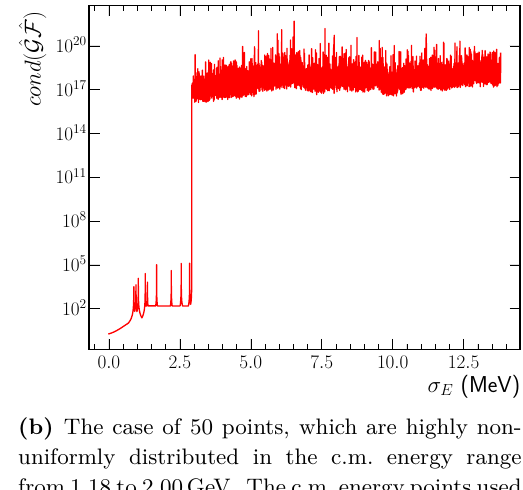
(b) The case of 50 points, which are highly non- uniformly distributed in the c.m. energy range from 1 . 18 to 2 . 00 GeV. The c.m. energy points used in this case correspond to figure 3.